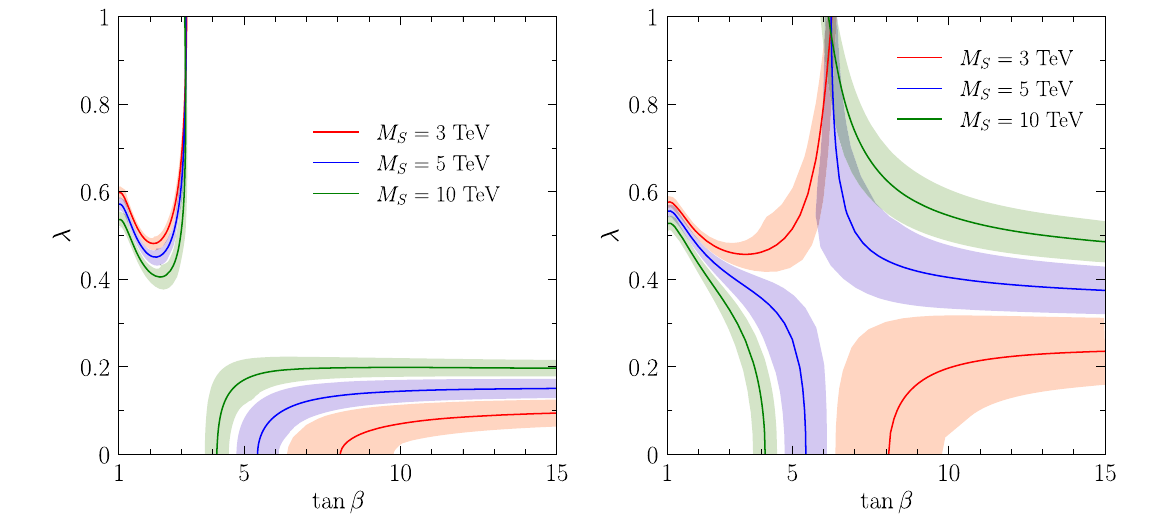
Fig. 2 Regions of the tan β – λ plane that yield M h = 125 . 25 GeV, for κ = λ (left) or κ = 2 λ (right), in the NMSSM scenario described in the text. The three sets of lines in each plot correspond to different values